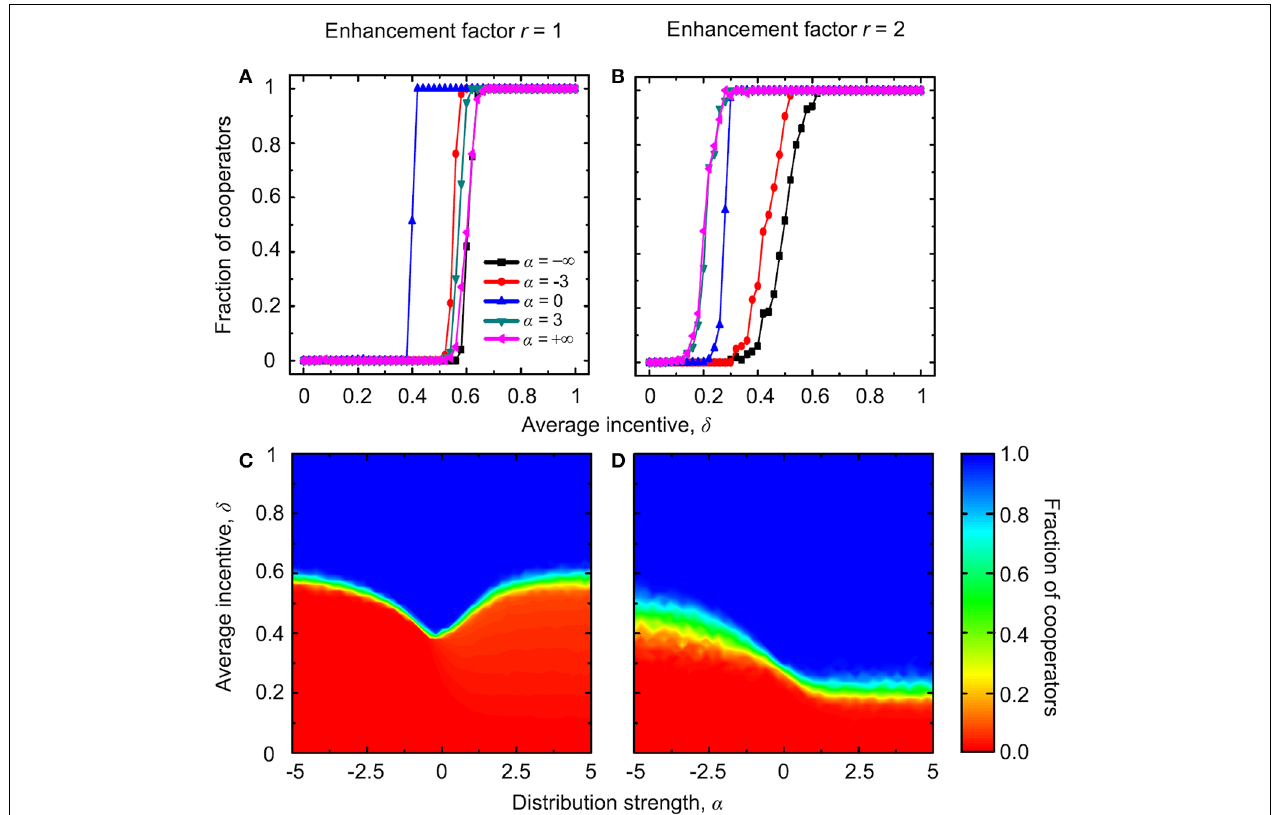
FIGURE 4 | Evolution of cooperation with institutional punishment and absolute payoffs. Top row depicts the stationary fraction of cooperators as a functionoftheaverageamountofavailableincentives δ fordifferentvaluesofthe